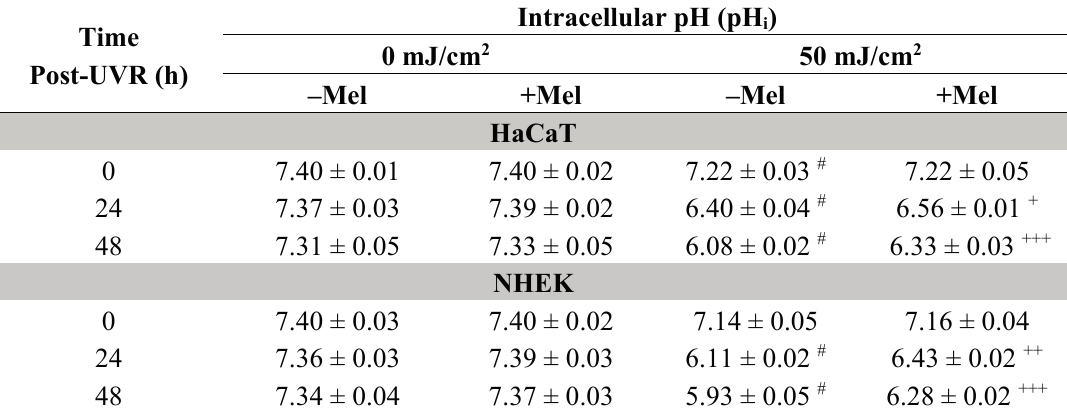
Table 1. Calculated pH i in human keratinocytes (HaCaT and NHEK). Cells were exposed to UVR and cultured post-UVR in time-dependent manner, stained with FDA, and analyzed for intracellular pH by flow cytometry. Data present pH i mean ± SEM of three independent experiments (modified after Kleszczy ń ski et al. [142] with permission from the publisher). Statistically significant differences compared to sham-irradiated cells at particular time end-points post-UVR without melatonin are presented as follows: # p < 0.001. Protective effect of melatonin compared to corresponding samples without melatonin was considered statistically significant and indicated as + p < 0.05, ++ p < 0.01, +++ p < 0.001. Intracellular pH (pH ) i Time 0 mJ/cm Post-UVR (h)